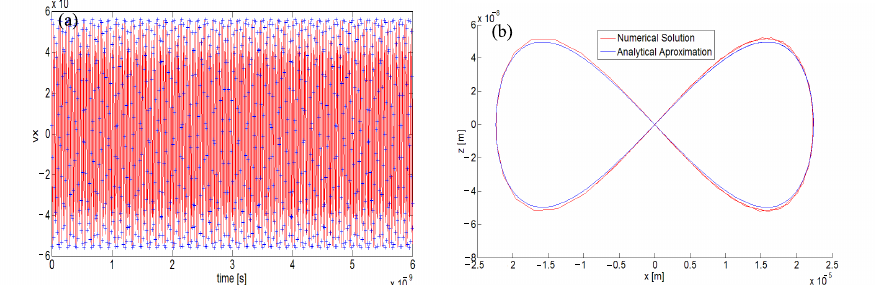
Figure 3. ( a ) X-component electron velocity (numerical red, blue crosses analytical); ( b ) eight-like motion in the laboratory frame (blue analytical, red numerical). We have plotted indeed z − ¯ v z t vs. x both evaluated in the laboratory